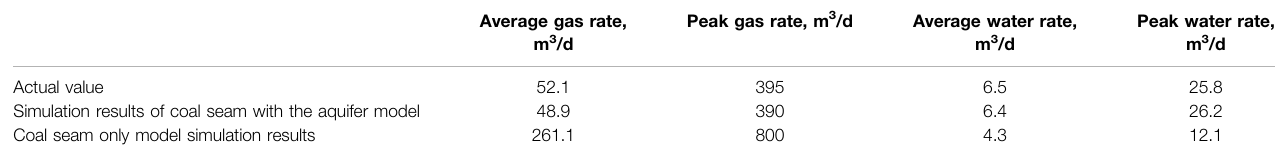
TABLE 2 | Comparison of fi tting results of different models with actual values.